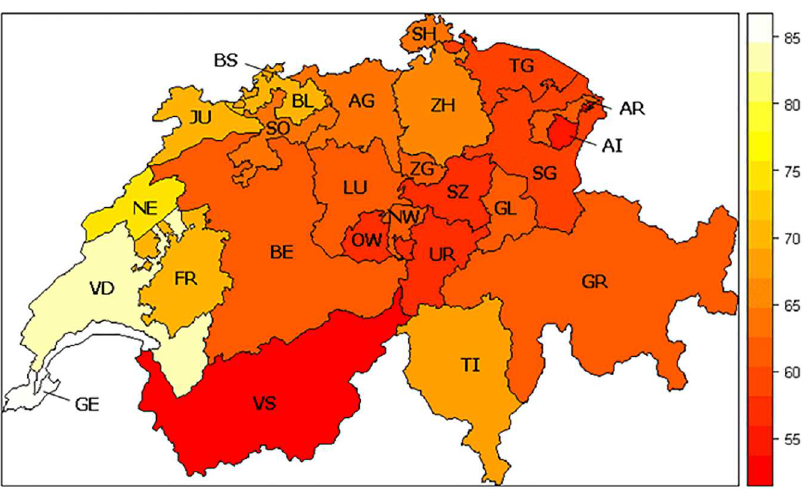
Fig 1. Acceptance rate of the proposed law among all 26 Swiss cantons. Cantons in central Switzerland were less likely to approvethe proposal,whilethe French and Italian speakingcantons were more likely to approveit. Source: Federal Statistical Office and Swissvotes